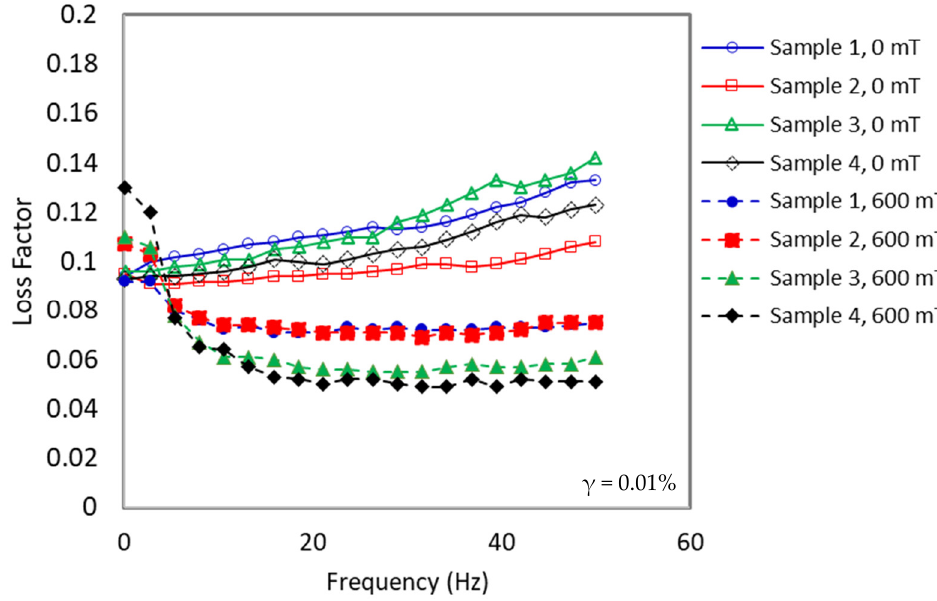
Figure 5. The loss factor of MRE samples as a function of the frequency at on- and off-state condi- tions.